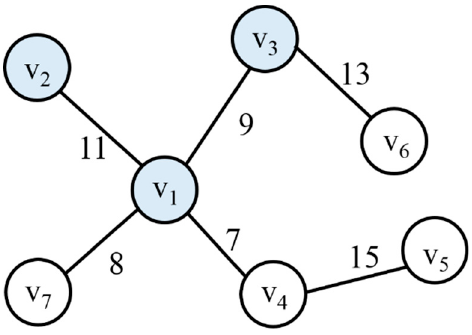
Figure 8. New requested query in the PC.